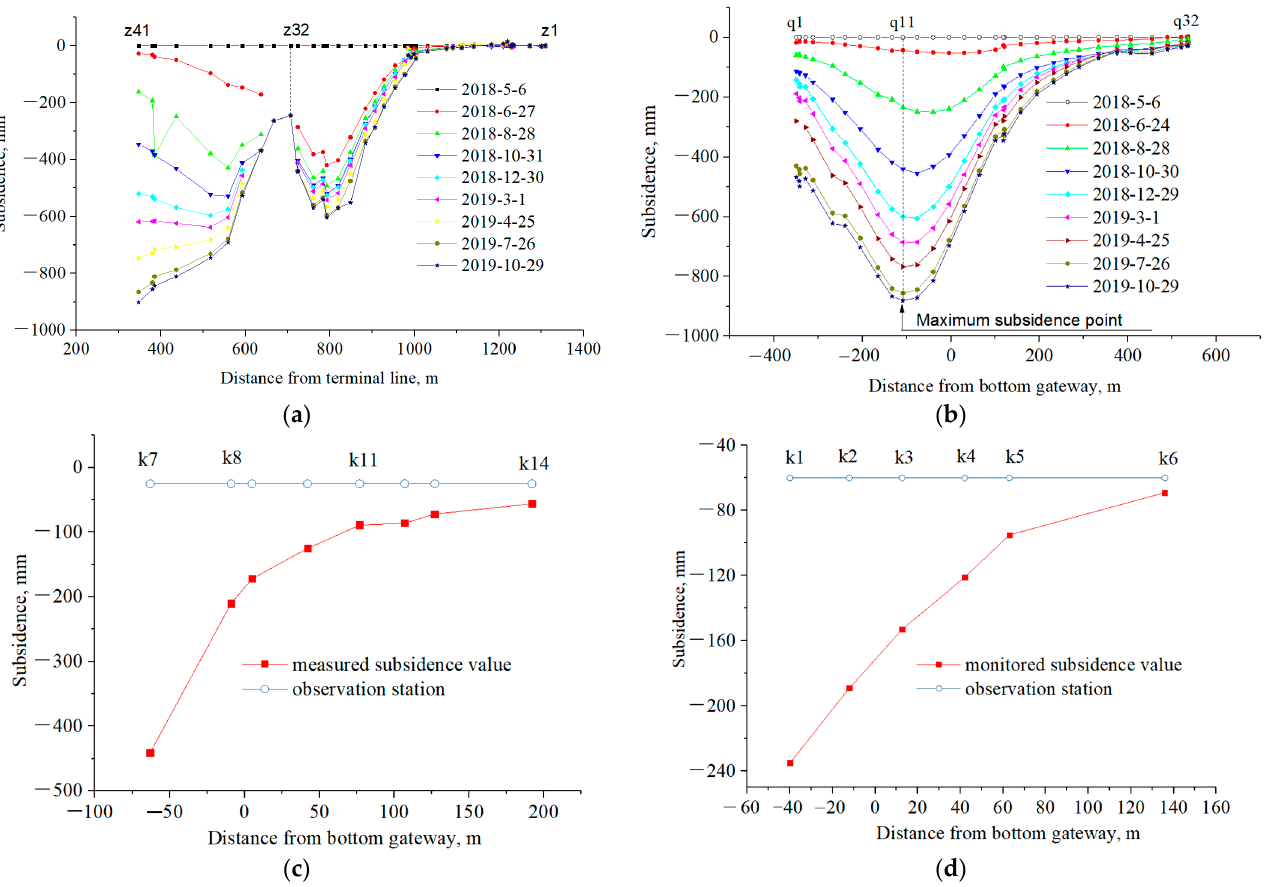
Figure 8. Field observed subsidence curves for different surveying lines: ( a ) line Z; ( b ) line Q; ( c ) line K 1 ; ( d ) line K 2 .